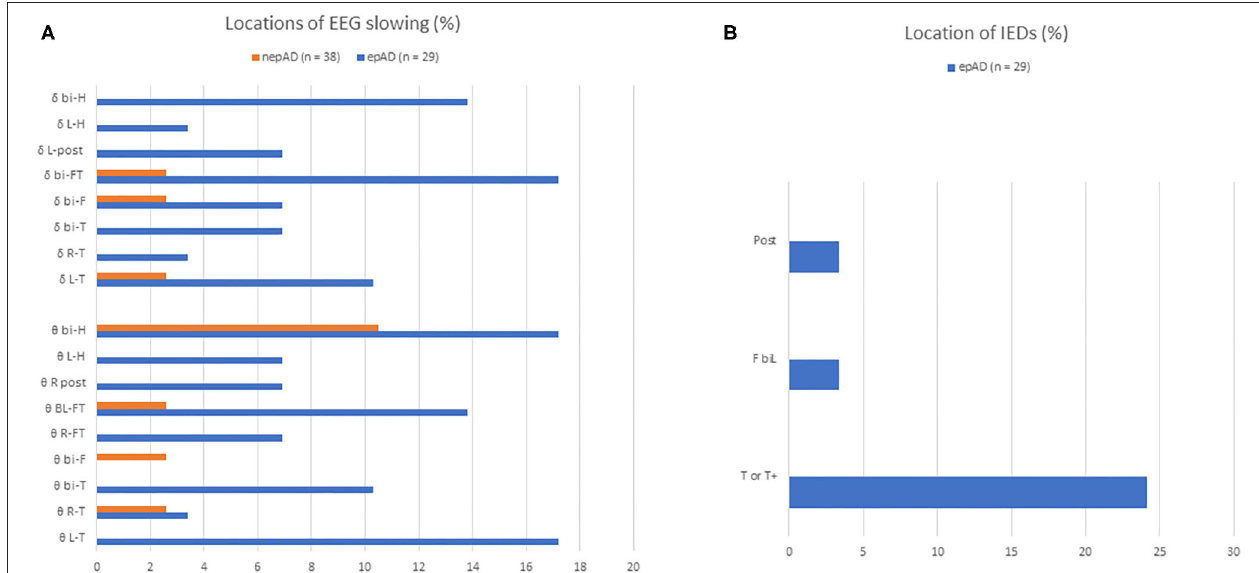
FIGURE 3 | EEG features of prodromal AD patients. (A) Distributions of non-epileptiform activity on EEG recordings; (B) distributions of epileptiform activity on EEG recordings; 1 delta slowing; θ , theta slowing; BI-F, bi-frontal; BI-FT, bi-fronto-temporal; BI-H, bi-hemispheric; BIL-F, bilateral frontal; BI-T, bi-temporal; BI-T/T + , bitemporal or bitemporal with extension to the frontal, central or posterior electrodes; L-H, left hemispheric; L-POST, left posterior (parieto-occipital); L-T, left temporal; L-T/T + , left temporal or left temporal with extension to the frontal, central or posterior electrodes; R-FT, right fronto-temporal; R-T, right temporal; R-T/T + , right temporal or right temporal with extension to the frontal, central or posterior electrodes; R-POST, right posterior (parieto-occipital).